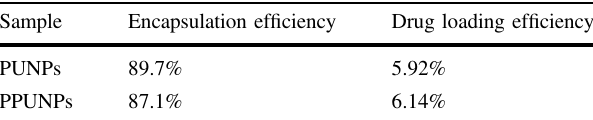
PUNPs and PPUNPs ( n = 3)